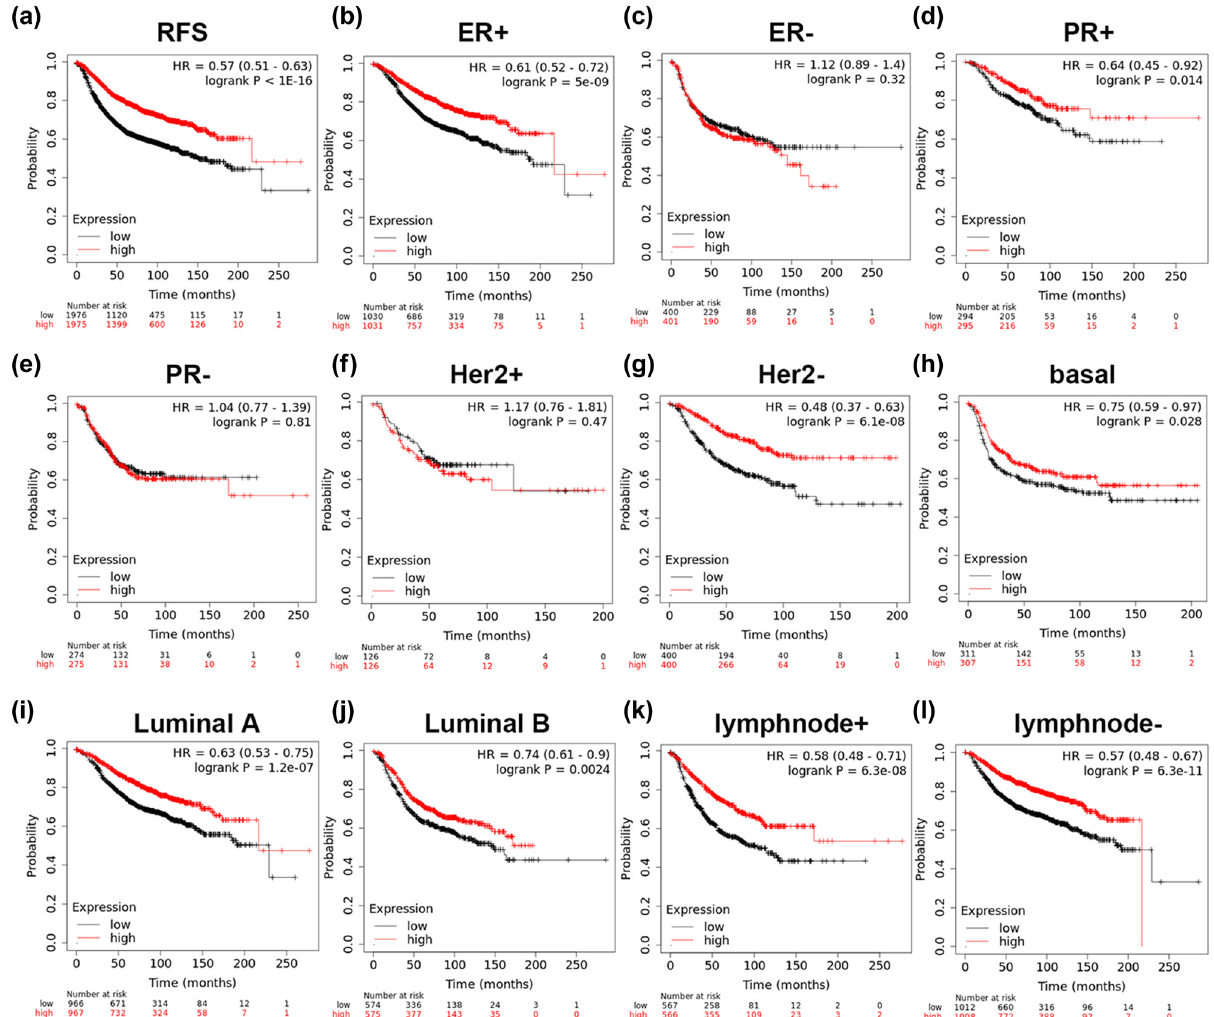
Figure 3: Analysis of the prognostic value of LIG1 in BC. The correlation of LIG1 expression with relapse free survival was analyzed by the Kaplan – Meier plotter in ( a ) all patients with breast cancer, and various subtypes of BC, including ( b ) ER - positive, ( c ) ER - negative, ( d ) PR - positive, ( e ) PR - negative, ( f ) Her2 - positive, ( g ) Her2 - negative, ( h ) basal - like, ( i ) luminal A, ( j ) luminal B, and ( k ) lymphnode - positive and ( l ) lymphnode -